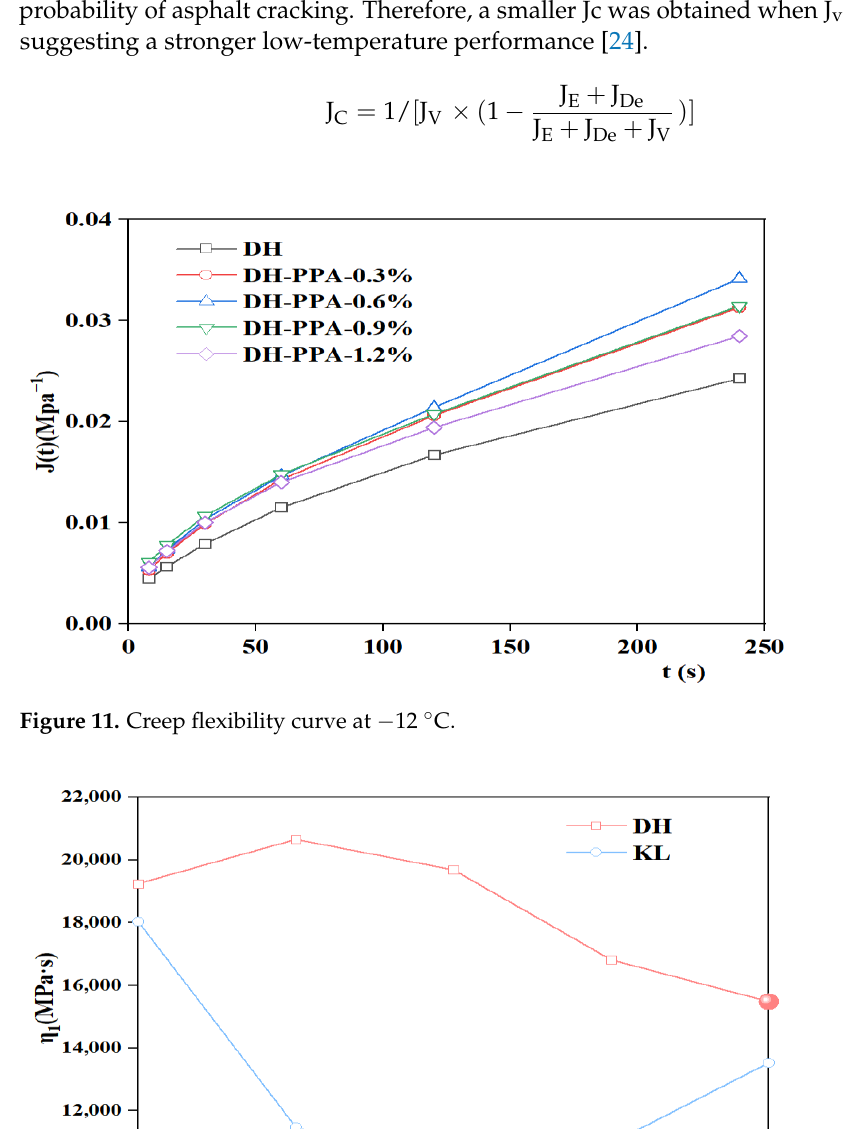
Figure 13. The η 1 value of composite modified asphalt with different PPA/SBR dosages.